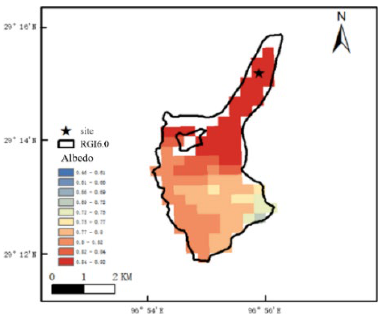
Figure 4. Sentinel-3 inversion of the albedo of Palong Glacier 4 on June 2017.